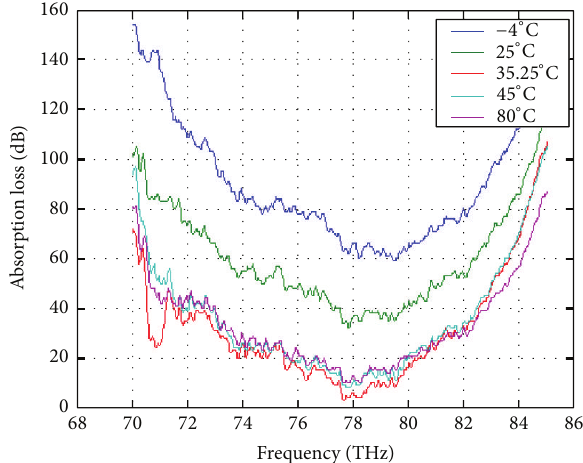
Figure 3: Absorption loss of pure water at 1mm distance between 70 and 85